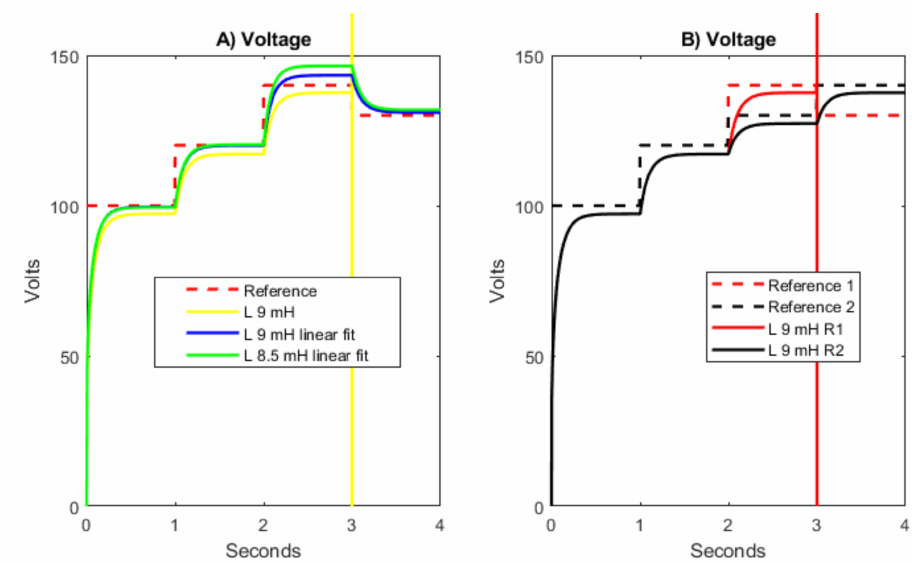
Figure 9. Comparison of the output voltage under changes in the inductance and the reference voltage, ( A ) with and without linear fit, ( B ) without linear fit, with two different accommodations of changes in